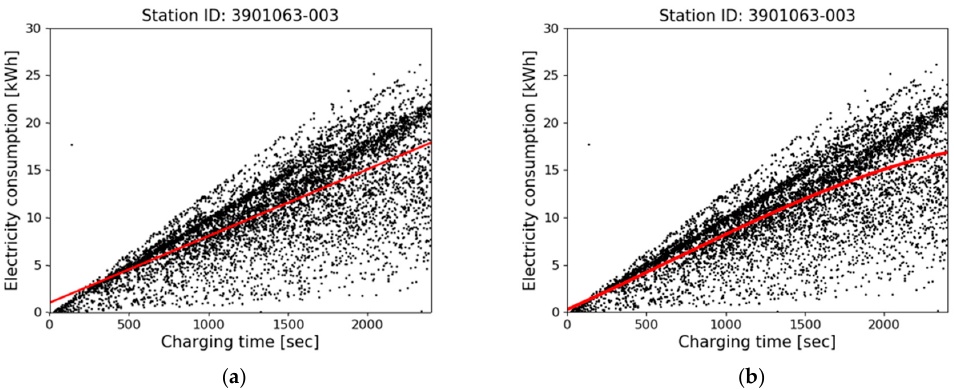
Figure 7. Generated regression curves for the sample station using ( a ) conventional linear regression curve and ( b ) the proposed non-linear regression curve.